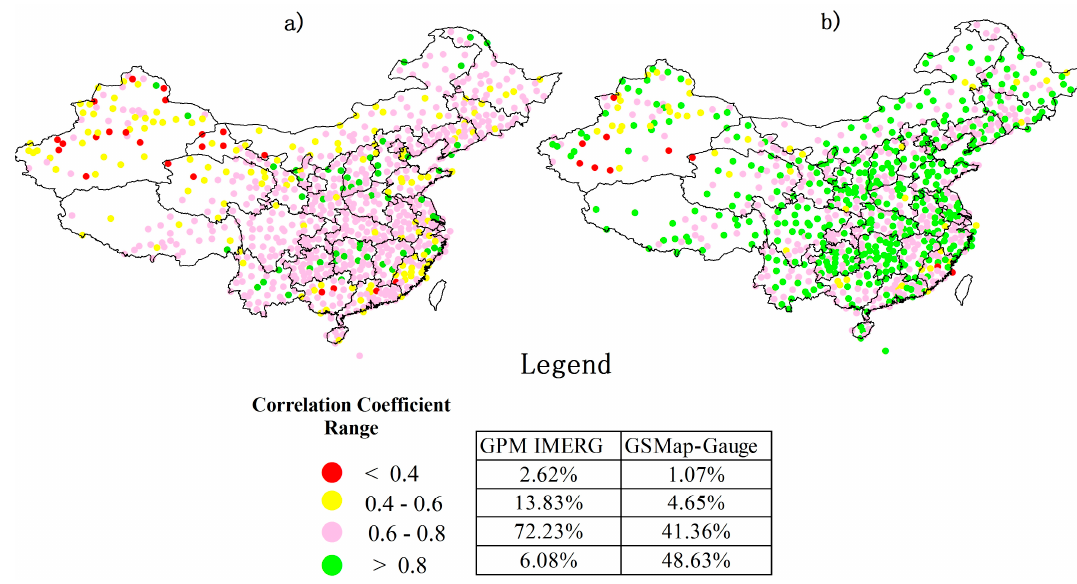
Figure 3. Distribution of CC between different satellite ‐ based products and precipitation gauge data over the Chinese mainland: ( a ) GPM IMERG; ( b ) GSMap ‐ Gauge.